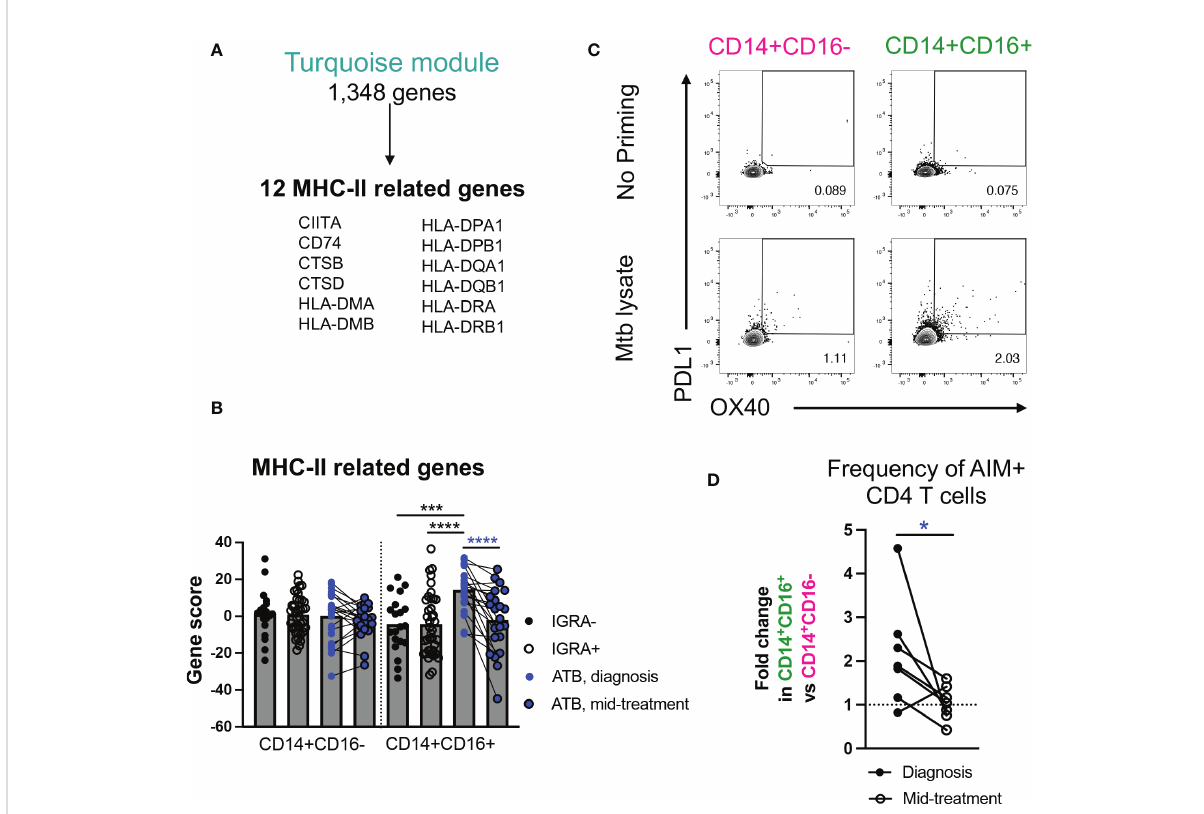
FIGURE 3 In ATB at diagnosis, intermediate CD14 + CD16 + monocytes are associated with upregulation of MHC-II gene signatures and increased capacity to activate T cells. (A) MHC-II related genes present in the turquoise module. (B) Combined MHC-II gene expression in CD14 + CD16 + and CD14 + CD16 - cells in ATB diagnosis, ATB mid-treatment, IGRA+ and IGRA- cohorts, calculated using a standard z-score formula. Individual gene expression is shown in Figure S3. (C) Representative staining of OX40 and PDL1 expression in CD4 T cells after co-culture with autologous Mtb - primed or unprimed CD14 + CD16 + and CD14 + CD16 - cells sorted from one ATB subject at diagnosis. (D) Fold change in the frequency of OX40 + PDL1 + cells in CD4 T cells after co-coculture with autologous Mtb -primed CD14 + CD16 + cells vs. CD14 + CD16 - cells sorted from ATB subjects at diagnosis, or mid-treatment. The frequency of OX40 + PDL1 + CD4 T cells induced after co-culture with unprimed CD14 + CD16 + or CD14 + CD16 - cells was used for background subtraction. (A, B) Data was from cryopreserved PBMC of 25 ATB subjects at diagnosis (with 22 paired mid-treatment samples), 40 IGRA+ and 20 IGRA- individuals. (C, D) Data was from cryopreserved PBMC of 7 ATB subjects with paired samples collected at diagnosis and mid-treatment. *p < 0.05, ***p < 0.001, ****p < 0.0001, nonparametric unpaired Mann-Whitney U test (black stars) and nonparametric paired Wilcoxon test (blue